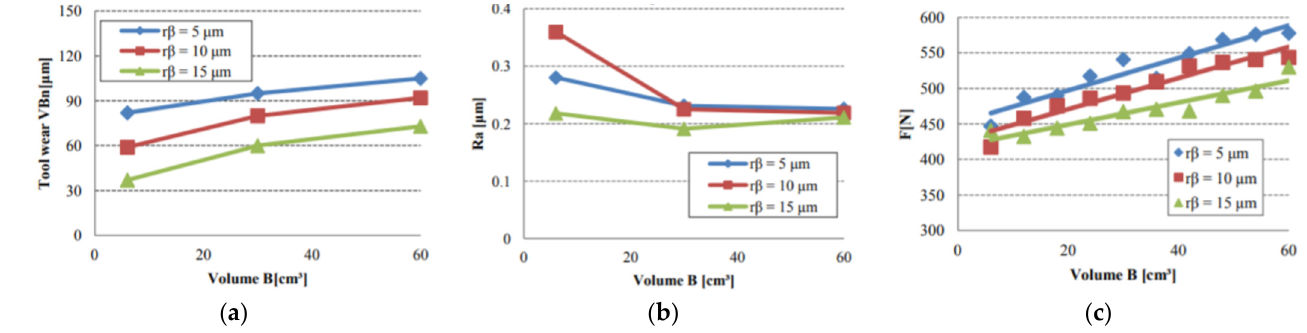
Figure 5. Influence of the cutting edge radius and machined volume on: ( a ) tool wear, ( b ) surface roughness, ( c ) cutting force [29].